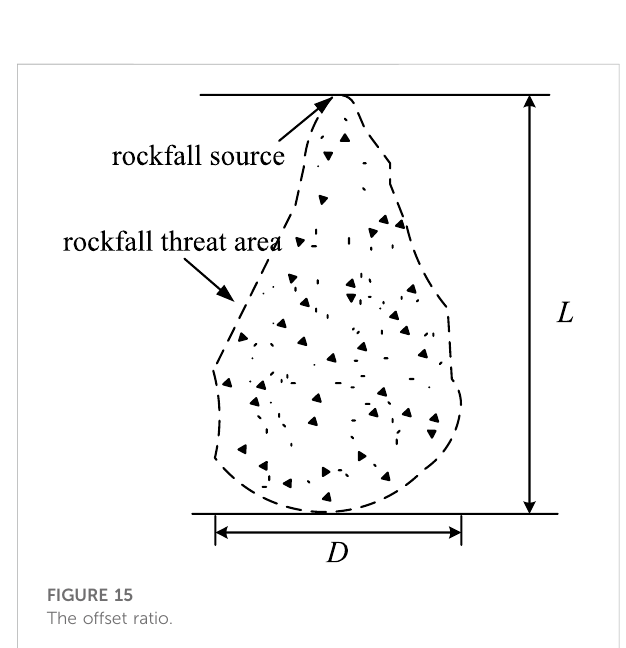
FIGURE 15 The offset